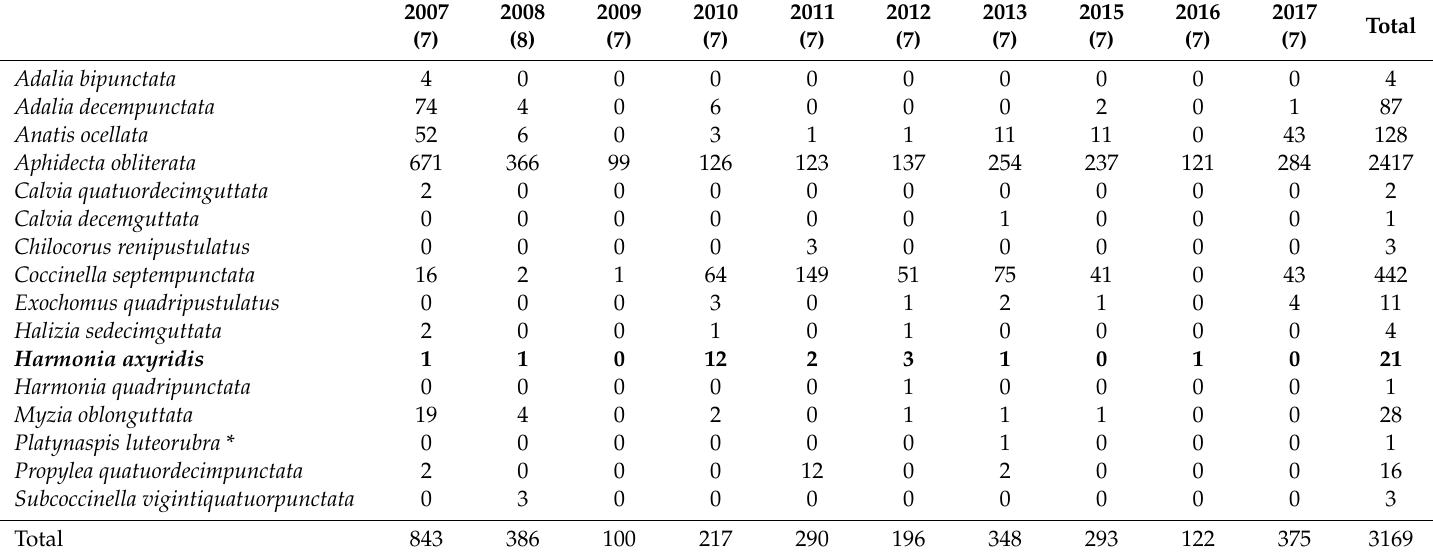
Table 4. Species and number of adult ladybirds collected at the five spruce sites from 2007 to 2017. Numbers between parentheses indicate the number of collections. Ladybirds were not sampled in